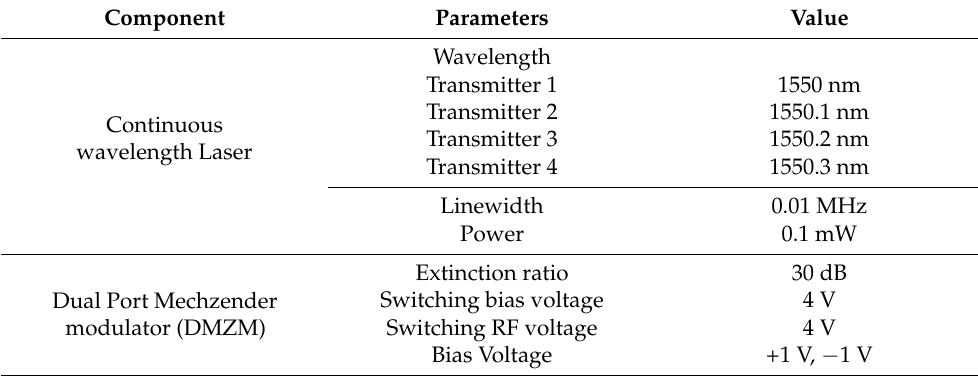
Table 1. System Modeling